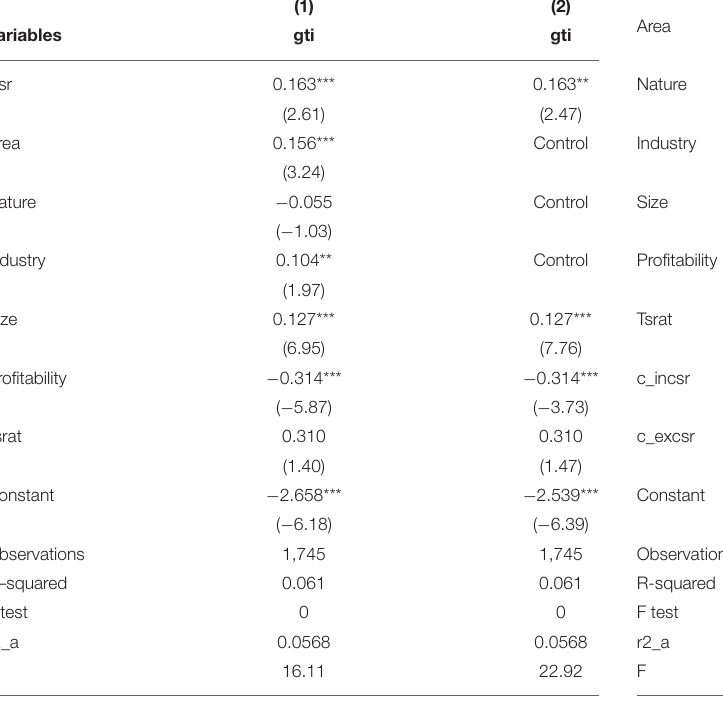
TABLE 7 | Results of mixed effect regression and REGHDFE